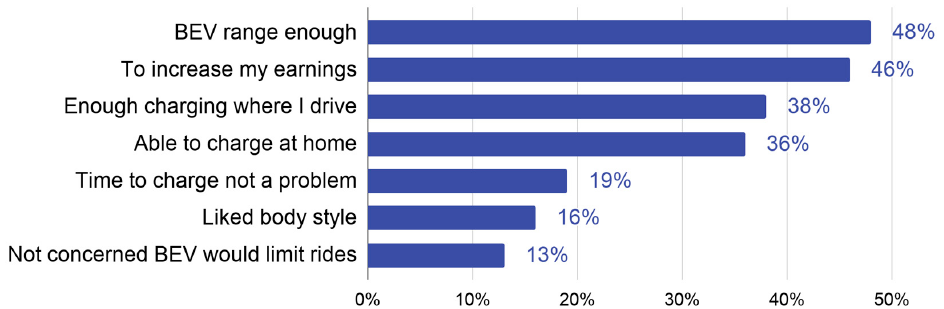
Figure 5. Reasons for choosing a BEV over a PHEV. Multiple answers allowed.